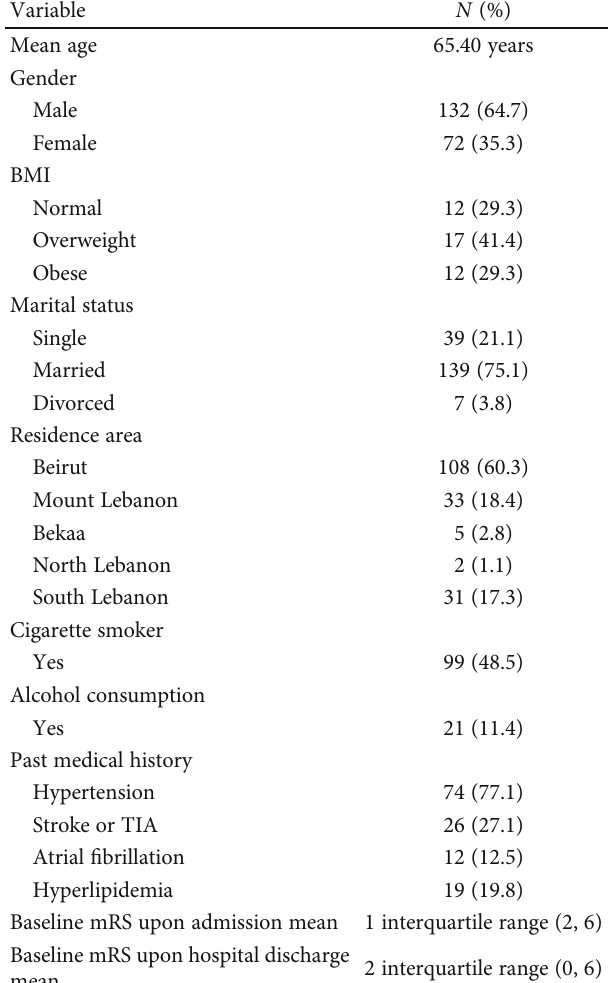
Table 1: Sociodemographic characteristics of the study